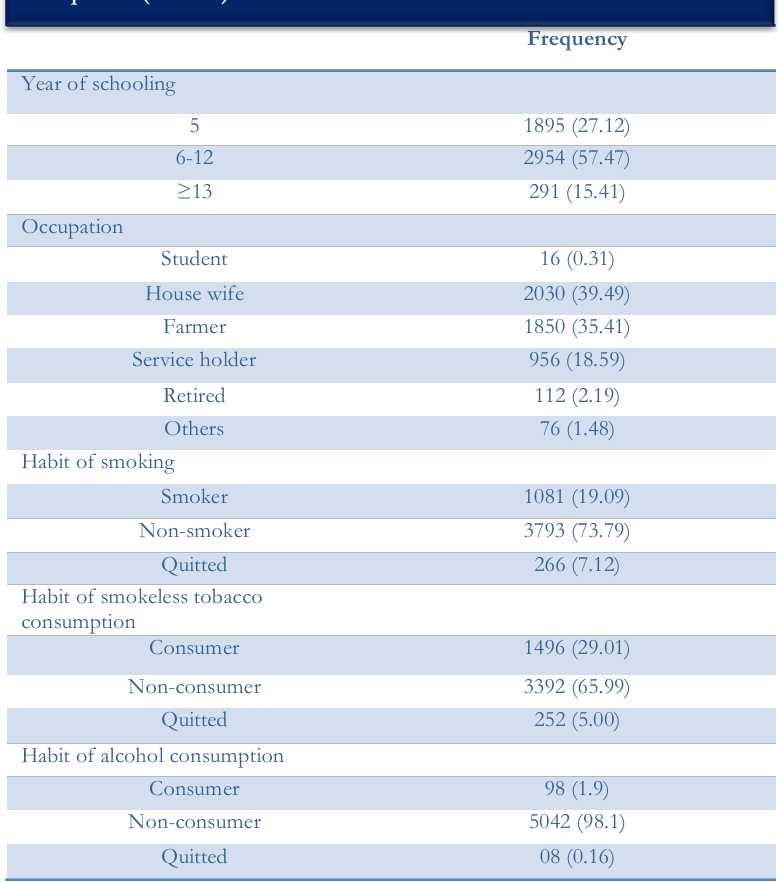
Table 2: Distribution of the respondents by level of education